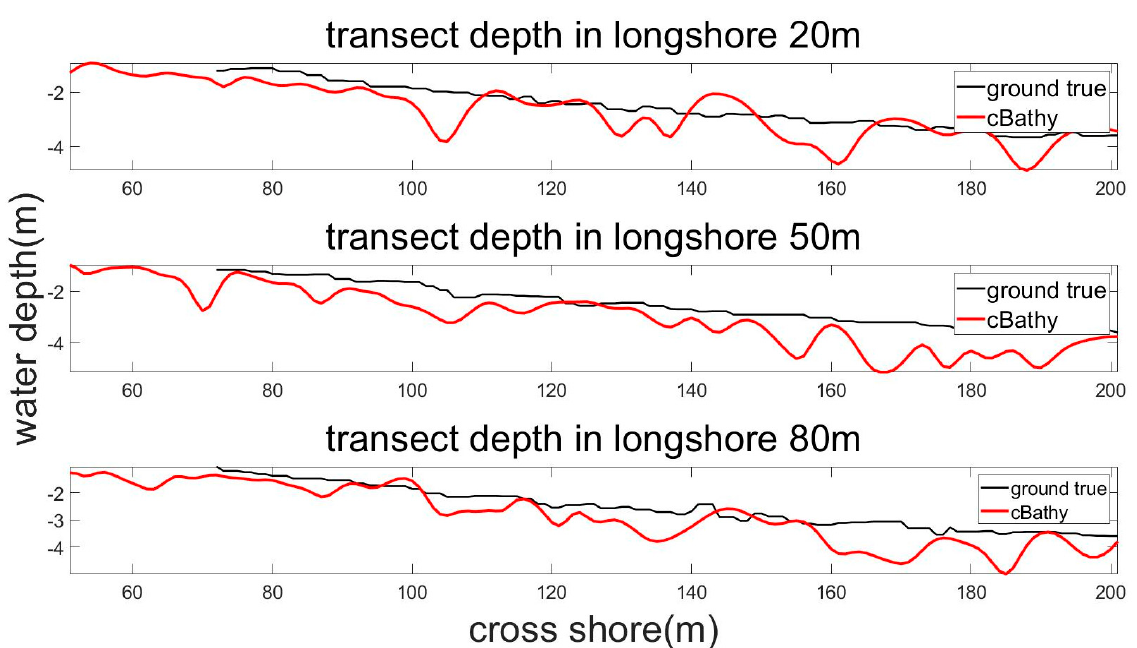
Figure 16. Comparison between ground true and the